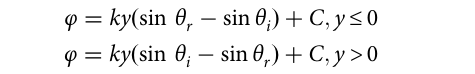
Fig. 5c, in this simulation, the plane wave radiation boundaries instead of hard boundaries are applied at the right modulators to mimic the opened boundaries. For FD case, the incident wave is focused at the coordinate (0.1, 0) at Region 2. For the BD case, the incident waves from the point source are transmitted to the right modulators and get totally radiated from the opened boundaries, leading to the effective sound absorption via sound leakage phenomenon 17 .